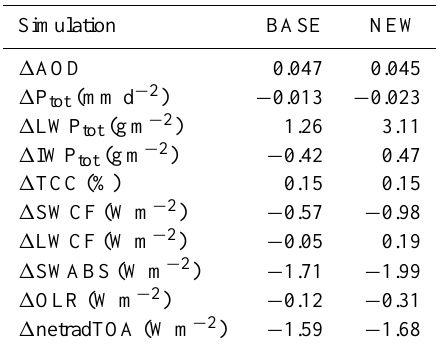
Table 3. Differences present-day minus pre-industrial aerosols 1 .